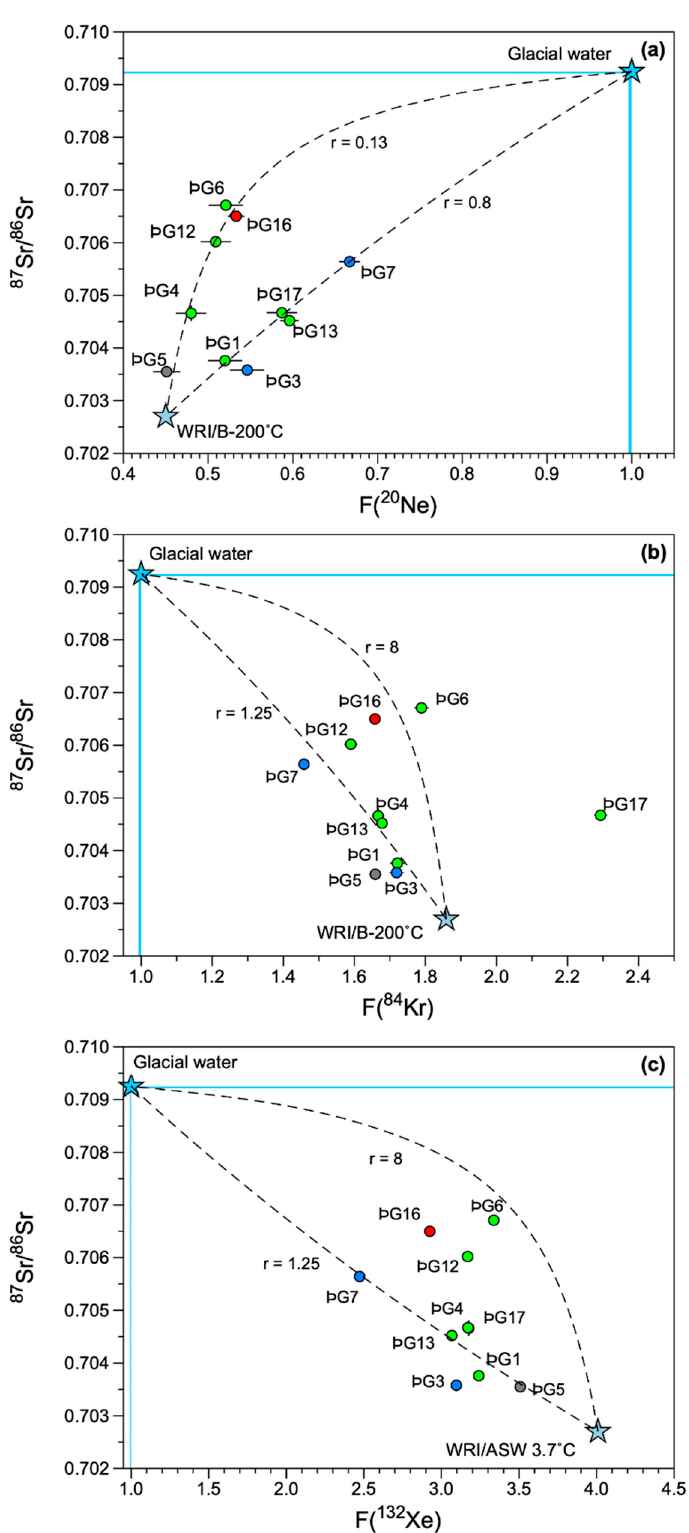
Figure 6. ( a ) F( 20 Ne), ( b ) F( 84 Kr) and ( c ) F( 132 Xe) vs. 87 Sr/ 86 Sr in the well fluids of Theistareykir. The dashed lines are mixing hyperbolas between meteoric fluids leaching Sr from basalts and ANG with an ASW fractionated composition and glacial water bringing seawater Sr and ANG with an atmospheric air composition.